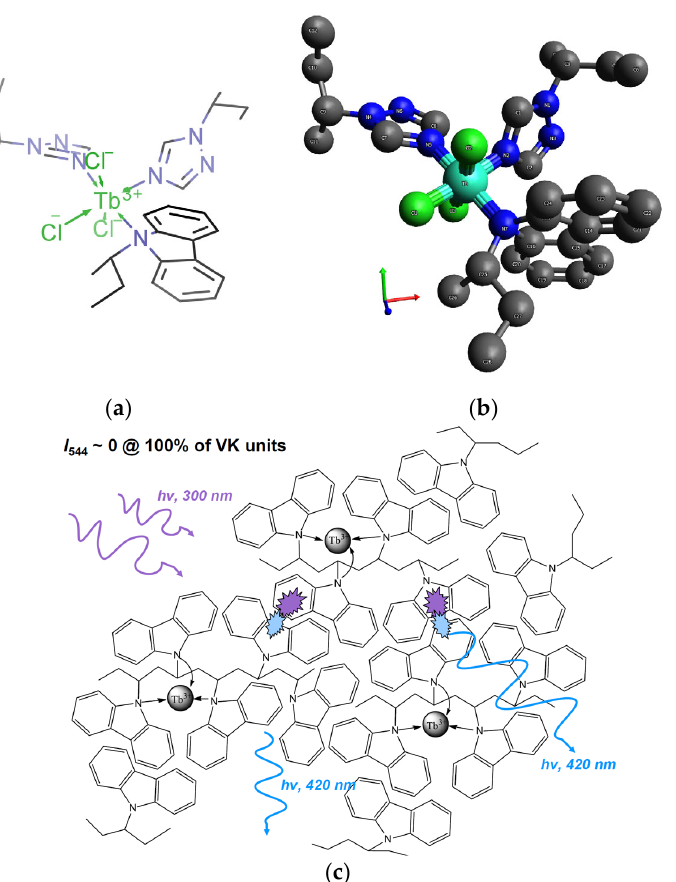
Figure 7. The structural scheme for the model of the Tb³ ⁺ complex proposed with poly(VT-co-VT) ( a , b ). Probable mechanism of excimer trapping in PVK ( c ).